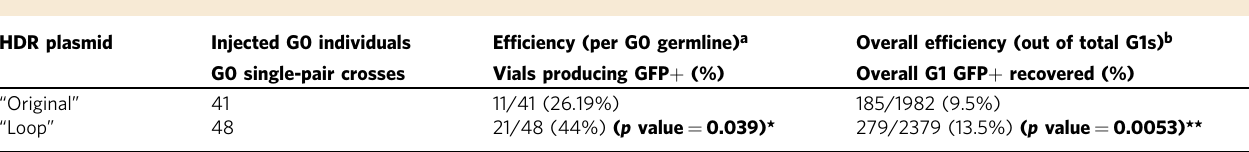
Table 2 Drosophila melanogaster transgenesis ef fi ciencies of different HDR